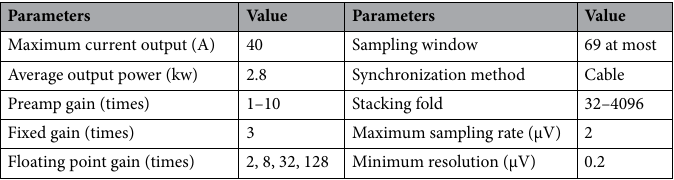
Table 1. Main performance parameters of TEM